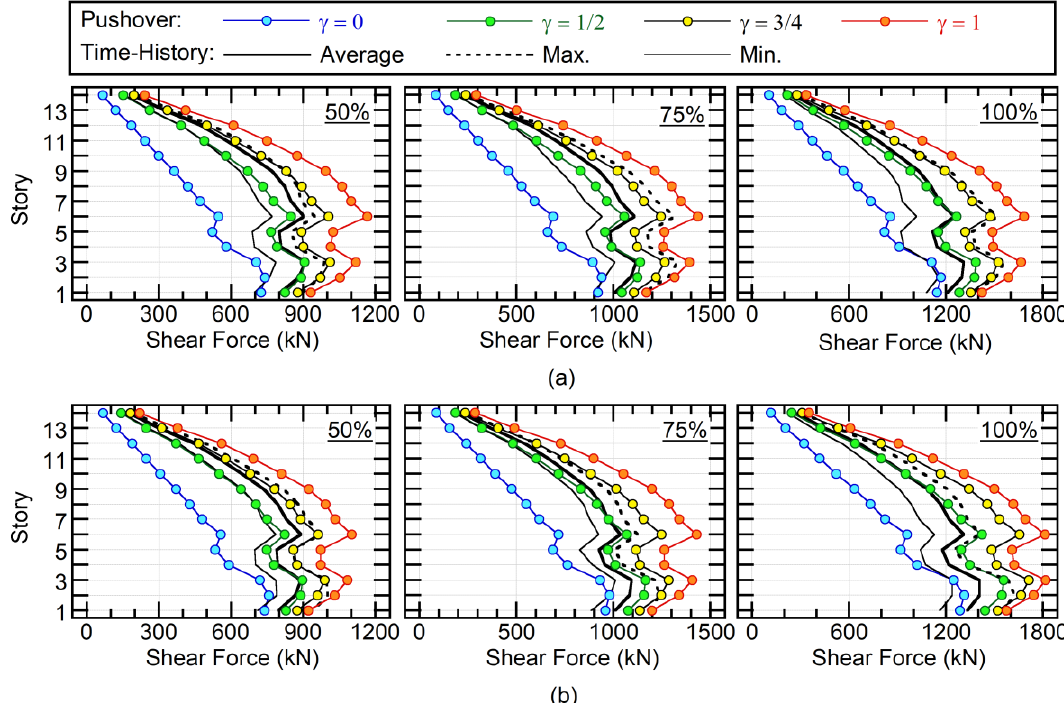
Figure 22. Comparison of the maximum shear force of column X 2 Y 2 in Model-14: ( a ) Art-S series and ( b ) Art-L series.